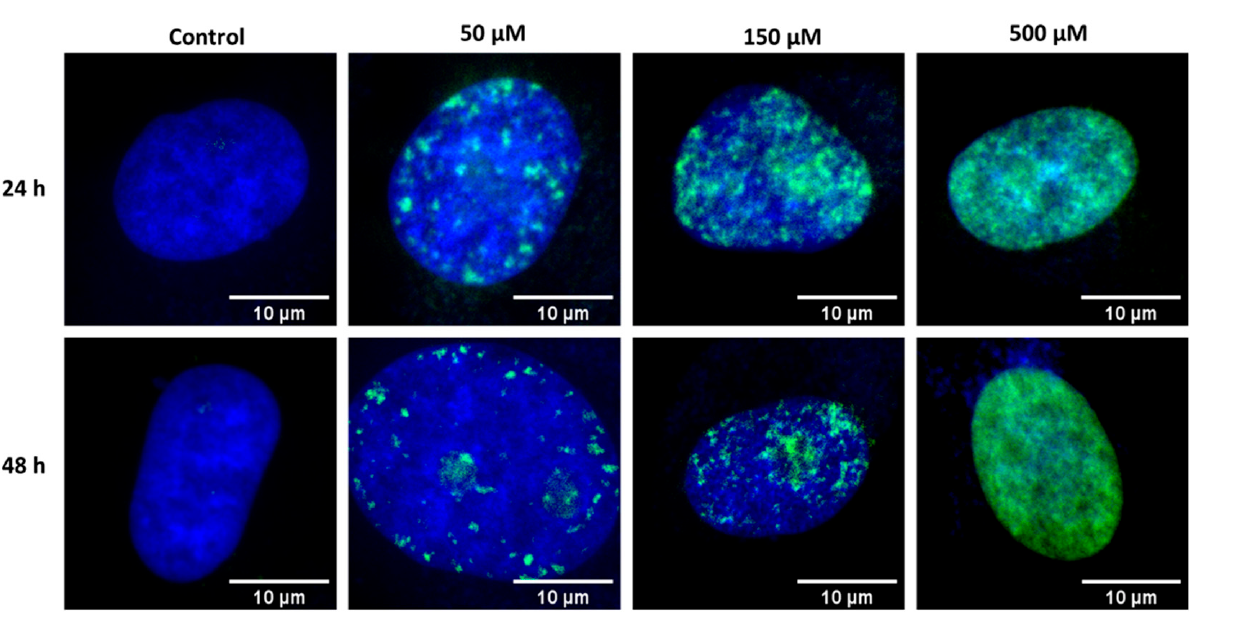
Figure 6. Fluoresce images of nuclei of individual fixed HeLa cells incubated with various bleomycin concentrations. From left to right side: control group, 50 µM of bleomycin, 150 µM, 500 µM. Top: 24 h of incubation; bottom: 48 h of incubation.